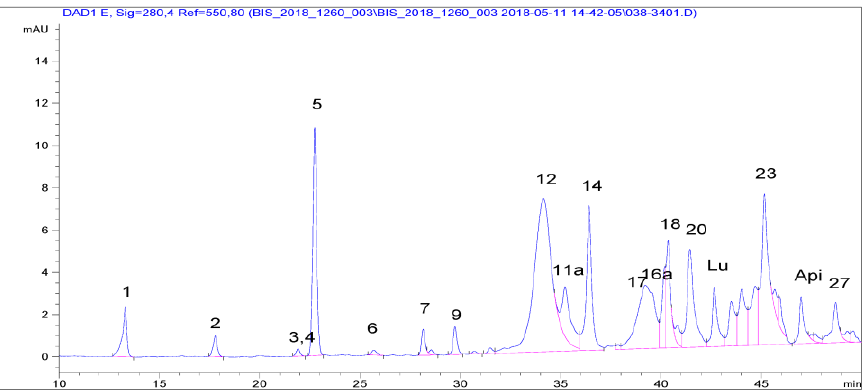
Figure 1. Typical chromatogram of virgin olive phenols present in the polar fraction at 280 nm